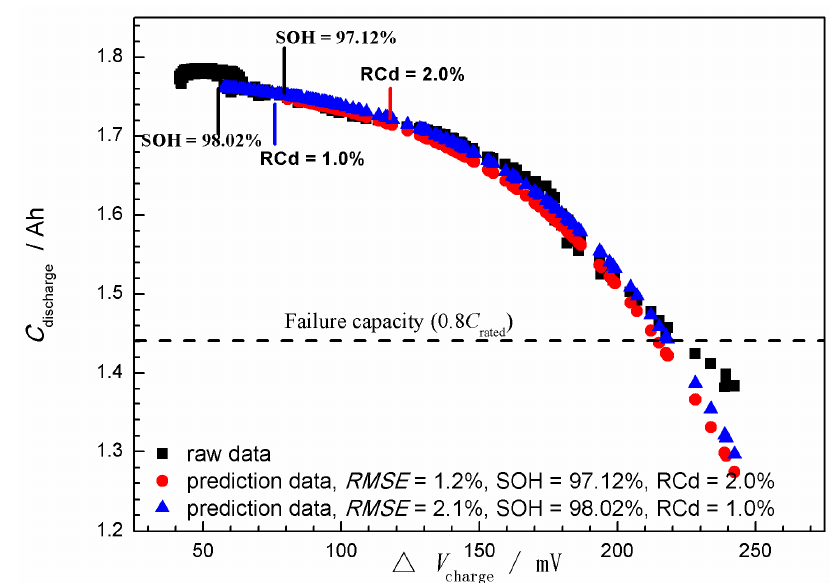
Figure 8. ( C discharge , ∆ V charge ) raw data used in Figure 7 and the prediction data with the best RMSE (1.2%) and the RMSE (2.1%) near the RMSE in Figure 7 (2.23%).